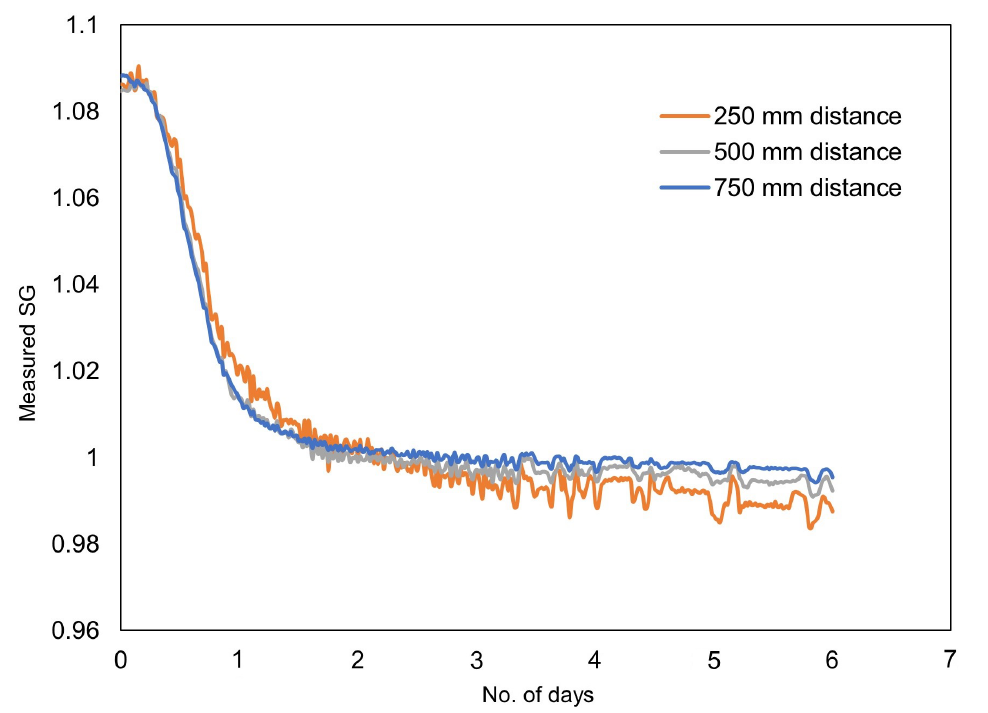
Figure 8. Effect of fermentation on the SG of the solution measured over 6 days with the proposed Brix sensor having pressure sensors 250 mm, 500 mm, and 750 mm apart.